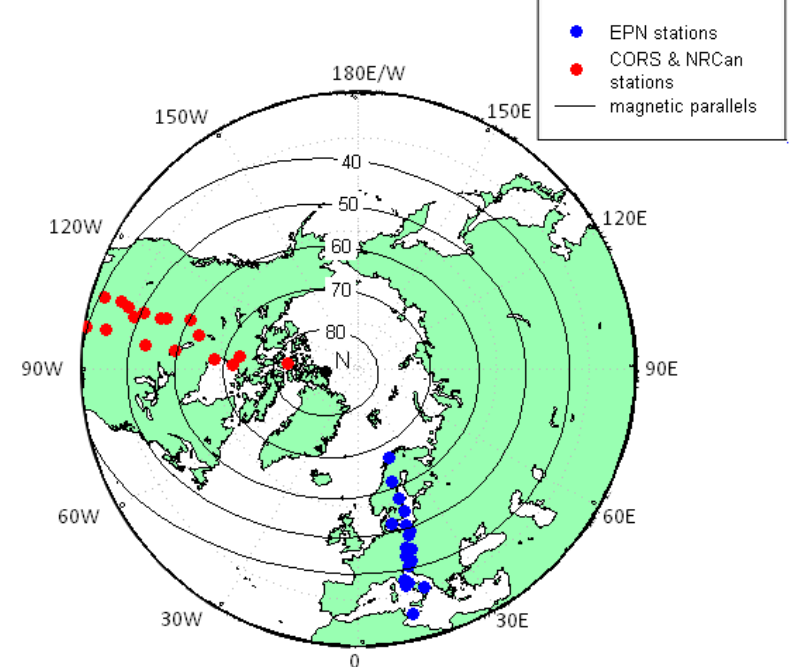
Figure 1. Polar view map with locations of the selected GNSS stations (color dots) in the European and North-American sectors. Thin black lines show the geomagnetic latitude isolines.